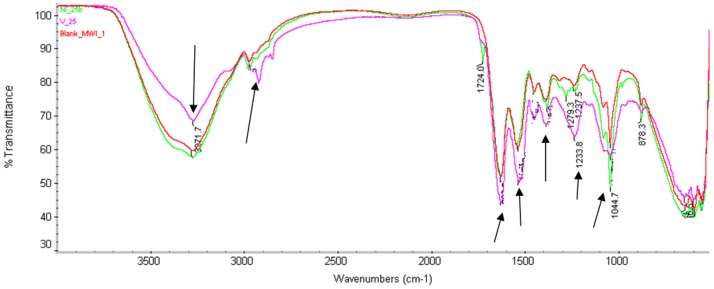
FTIR spectra of Marinobacter sp. MWI-1 before and after exposure to test metals.